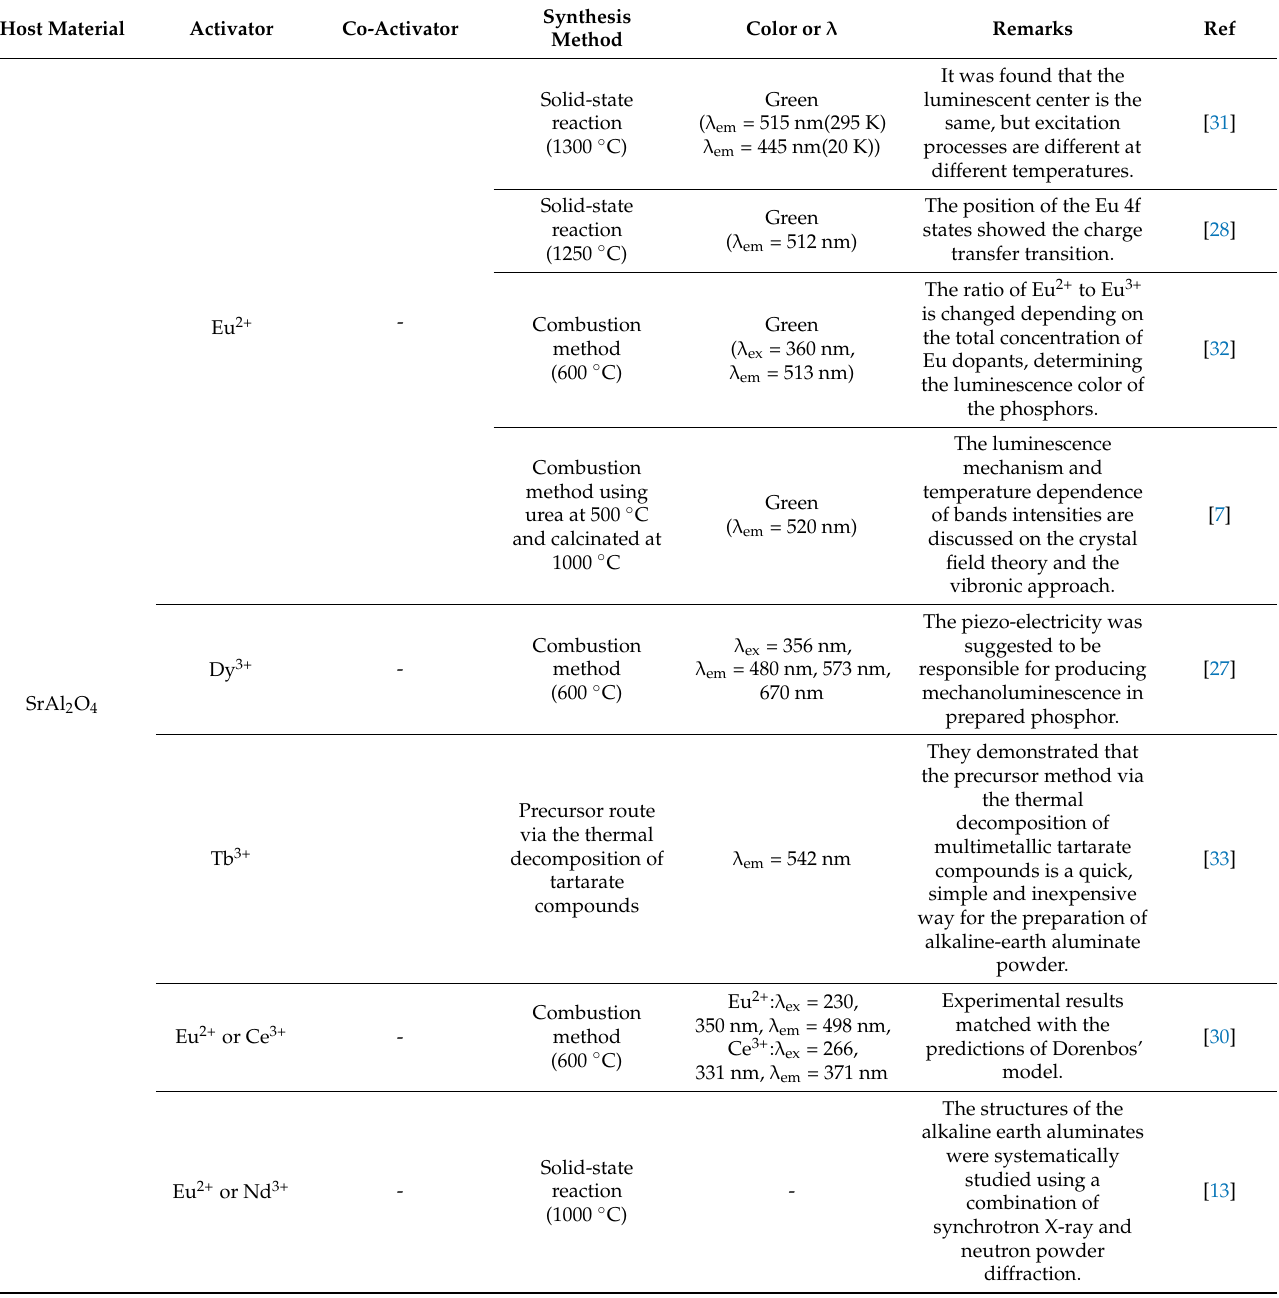
Table 1. Comparison of reported studies for the synthesis of lanthanide-doped strontium aluminate phosphors. Host